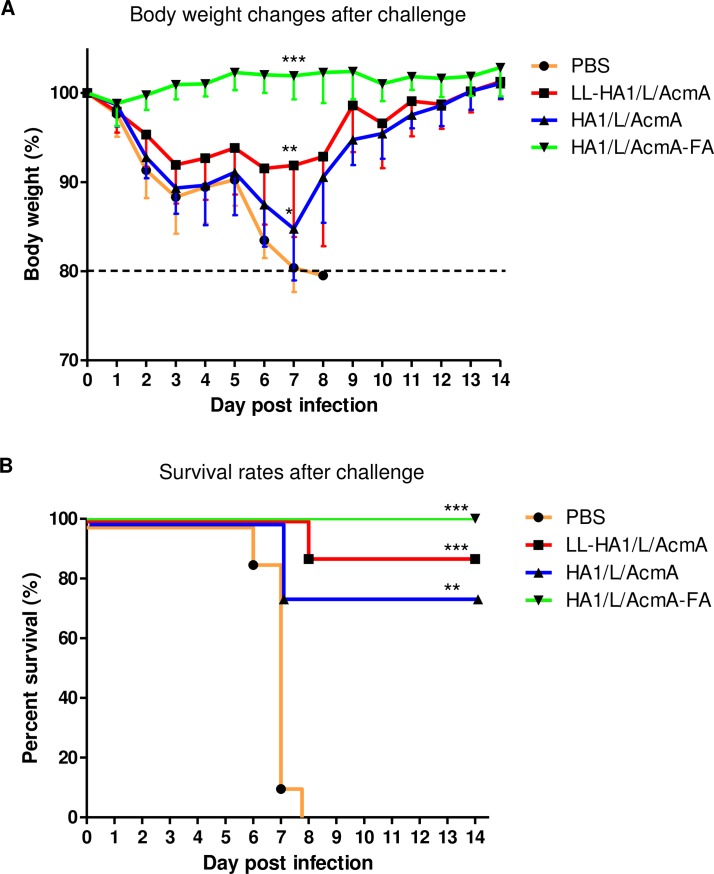
Body weight and survival rate of mice following lethal challenge with influenza virus.At 18 days following the last immunization, all mice in study group B were intranasally challenged with 10 LD50 of H1N1/A/TN/1-560/2009-MA2 virus. (A) Body weight and (B) survival of mice orally immunized with PBS, LL-HA1/L/AcmA or HA1/L/AcmA, or subcutaneously immunized with HA1/L/AcmA-FA, was monitored daily for 14 days following virus challenge. The body weight of mice on the day of viral challenge was used as the baseline weight to determine the body weight changes post-viral challenge. Asterisks indicate statistically significant differences in comparison with the PBS-treated group (*p<0.05; **p<0.01; ***p<0.001).